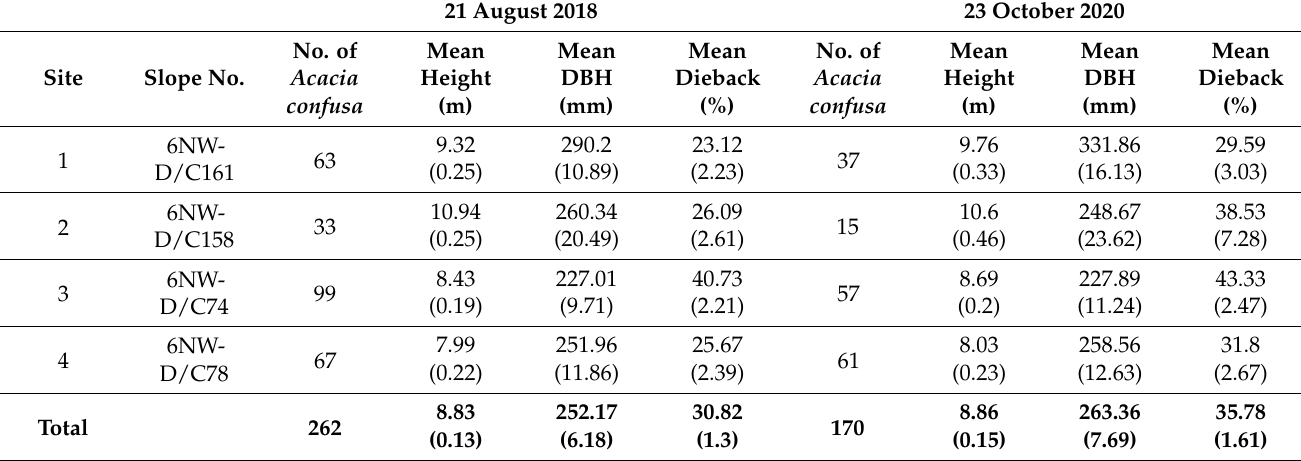
Table 4. Mean height, DBH, and dieback percentage of A. confusa in the study sites in Aug 2018 and Oct 2020. Values in parenthesis represent standard error of